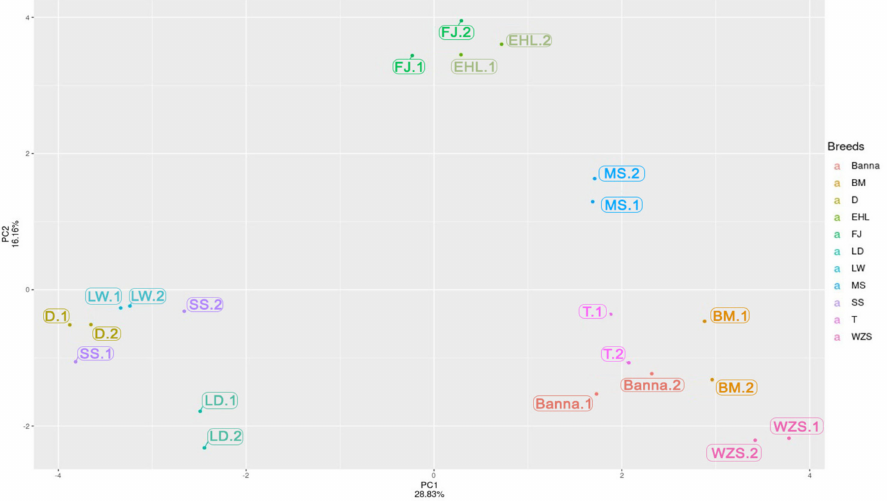
Figure 3. Principal Component Analysis (PCA) based on the results of the pool-PCR result. Table 2. The predicted RIP-sites’ information, which can be detected in different small group pig breeds.